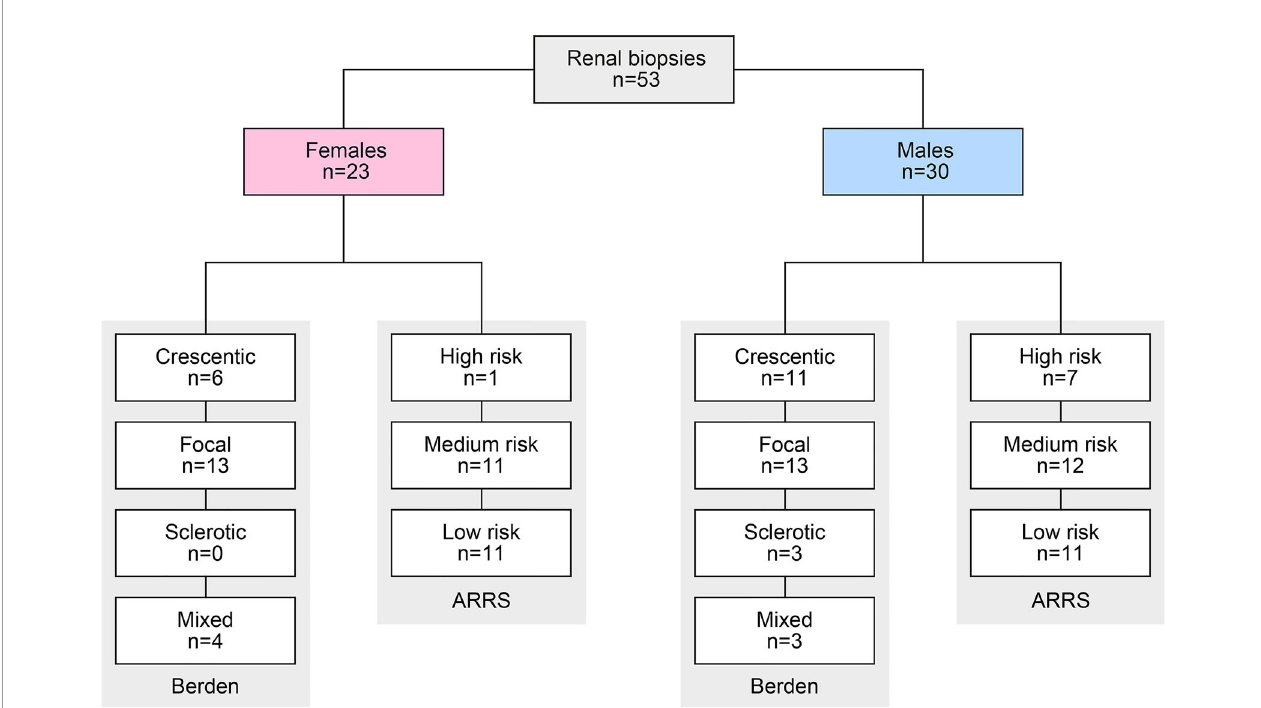
FIGURE 1 | Total patient cohort of ANCA GN. STROBE fl ow chart of the patient disposition. ANCA, anti-neutrophil cytoplasmic antibodies; ARRS, ANCA renal risk score; GN, glomerulonephritis; STROBE, Strengthening the Reporting of Observational Studies in